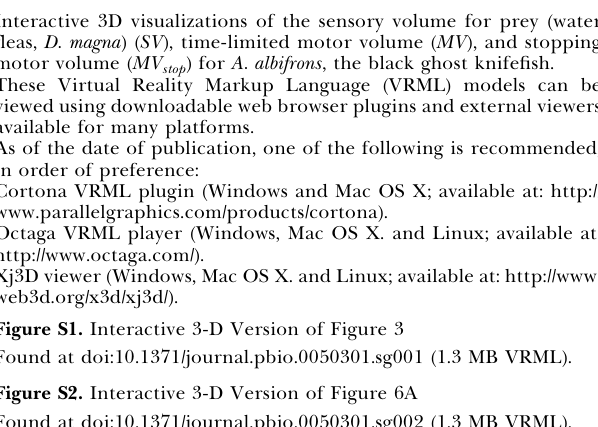
Figure S1. Interactive 3-D Version of Figure 3 Figure S2. Interactive 3-D Version of Figure 6A Found at doi:10.1371/journal.pbio.0050301.sg002 (1.3 MB VRML). Figure S3. Interactive 3-D Version of Figure 6B Found at doi:10.1371/journal.pbio.0050301.sg003 (1.7 MB VRML). Figure S4. Sensory Volume (Red) and Time-Limited Motor Volume MV ð V 9 0 ; (cid:3) T Þ (Blue) at the Time of Maximal Overlap between SV and MV ( t ¼ 432 ms) Found at doi:10.1371/journal.pbio.0050301.sg004 (1.6 MB VRML). Figure S5. Interactive 3-D Version of Figure 6C Found at doi:10.1371/journal.pbio.0050301.sg005 (1.6 MB VRML). Figure S6. Interactive 3-D Version of Figure 7 Found at doi:10.1371/journal.pbio.0050301.sg006 (1.4 MB VRML). Figure S7. Interactive 3-D Version of Figure 8 Found at doi:10.1371/journal.pbio.0050301.sg007 (1.8 MB VRML). Text S1. Technical Definition of Motor Volume and Stopping Motor Volume Found at